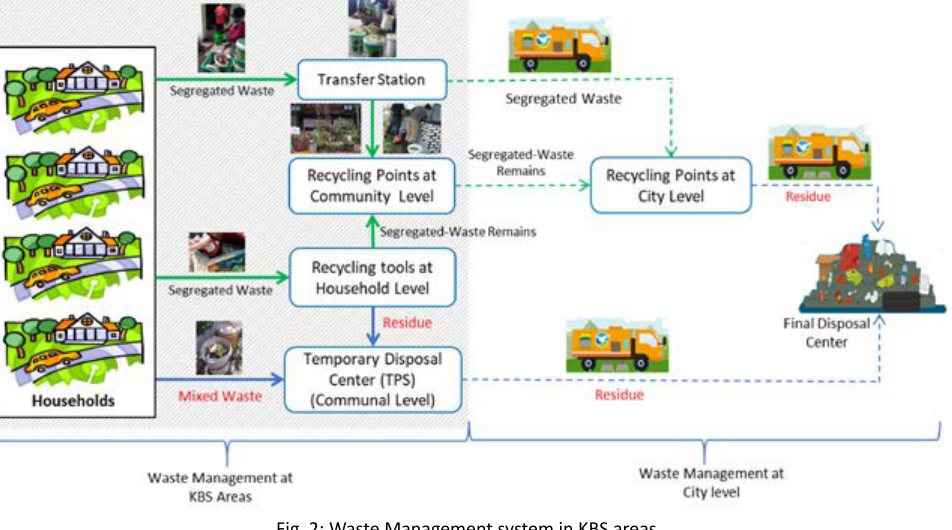
Fig. 2: Waste Management system in KBS areas